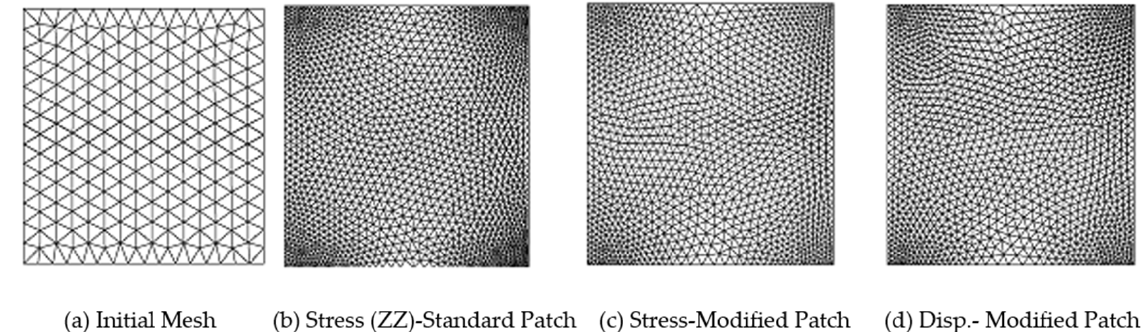
Figure 8. Adaptively modified mesh in benchmark plate problem using stress/displacement recovery and patch configu- ration (triangular elements initial mesh = 395.4% target error).